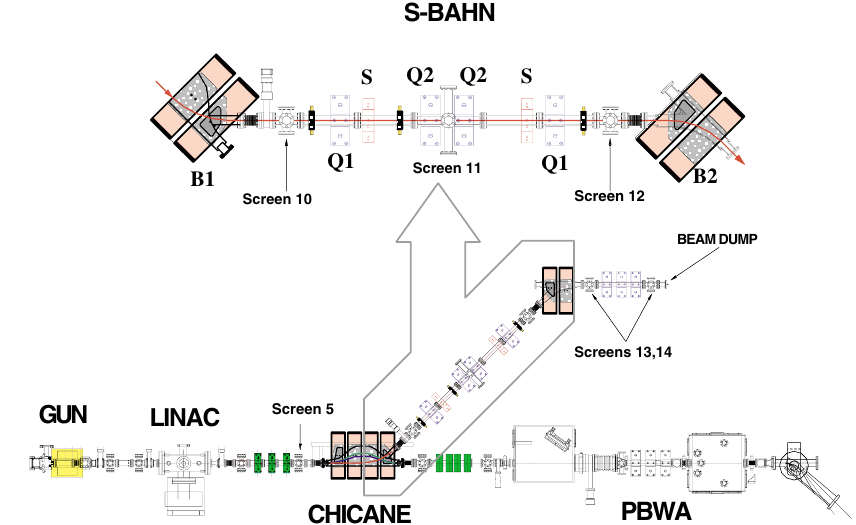
FIG. 5. (Color) Schematic of the linear accelerator beam line at the UCLA-Neptune Laboratory, with a blowup of the S-Bahn dogleg